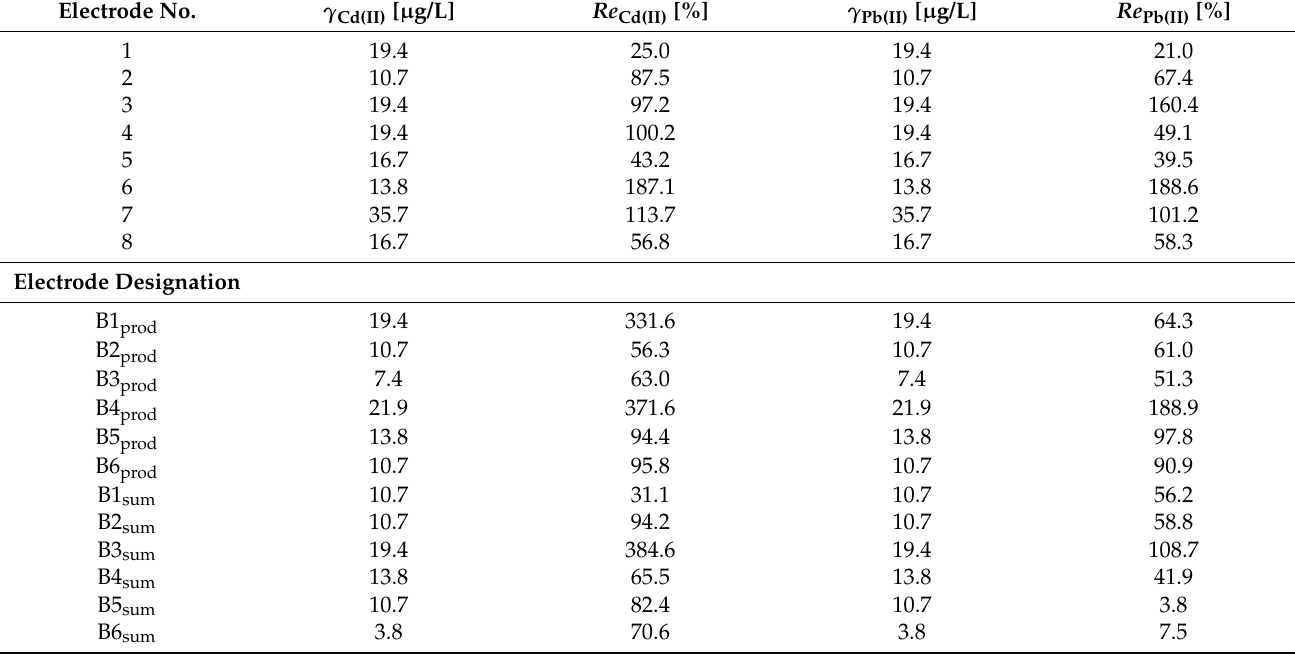
Table 9. Re values for different